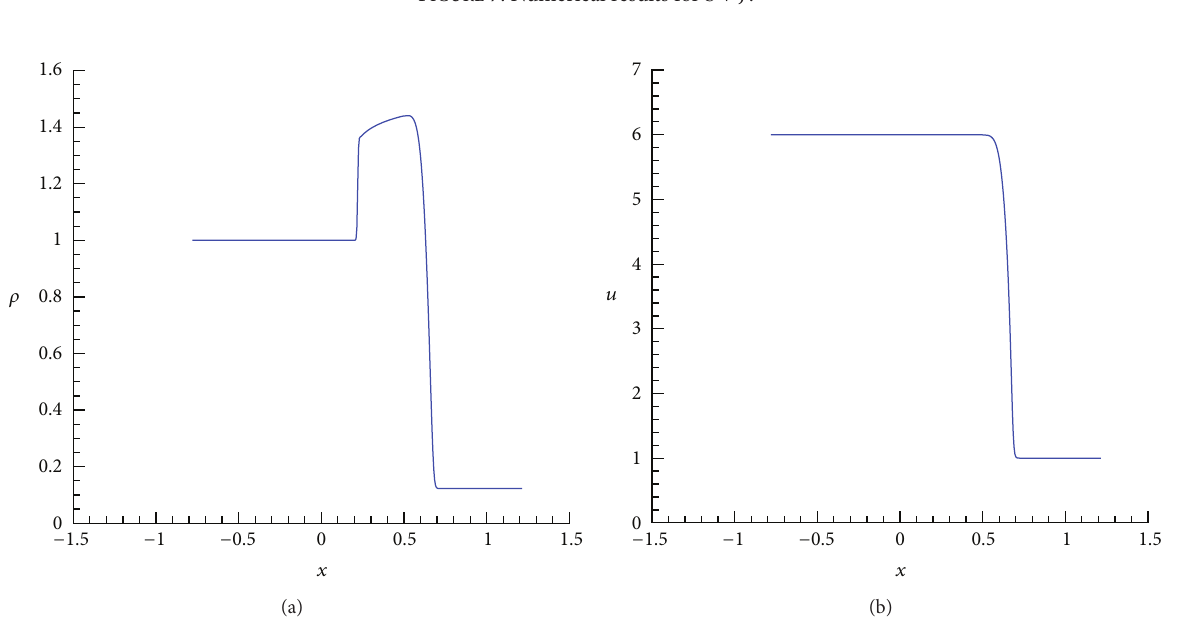
Figure 7: Numerical results for 𝑆 + 𝐽 .